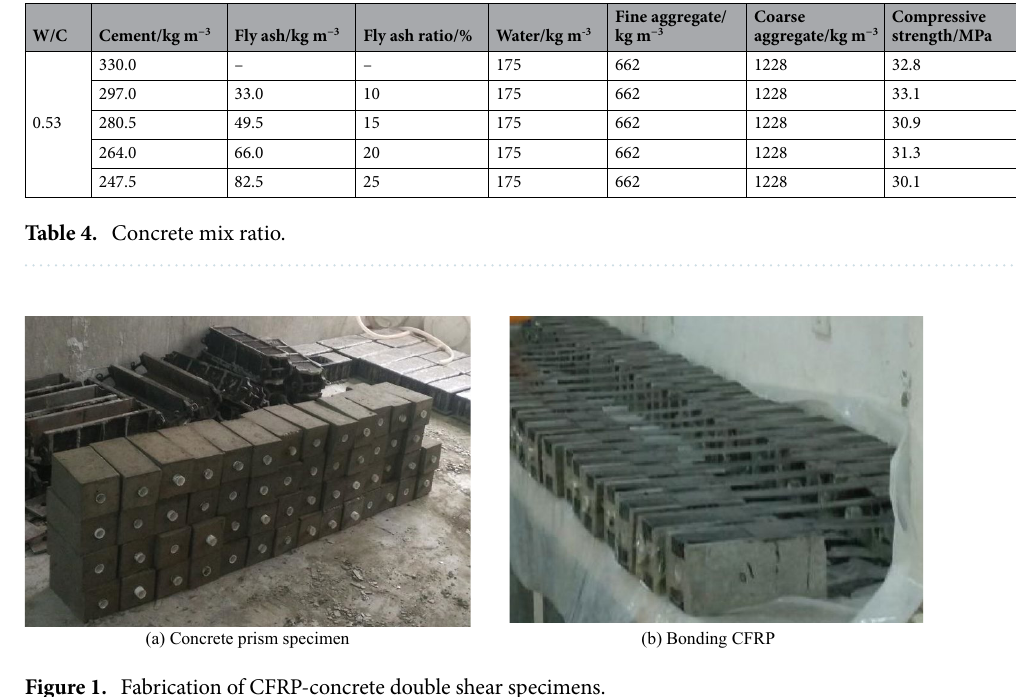
Figure 1. Fabrication of CFRP-concrete double shear specimens.